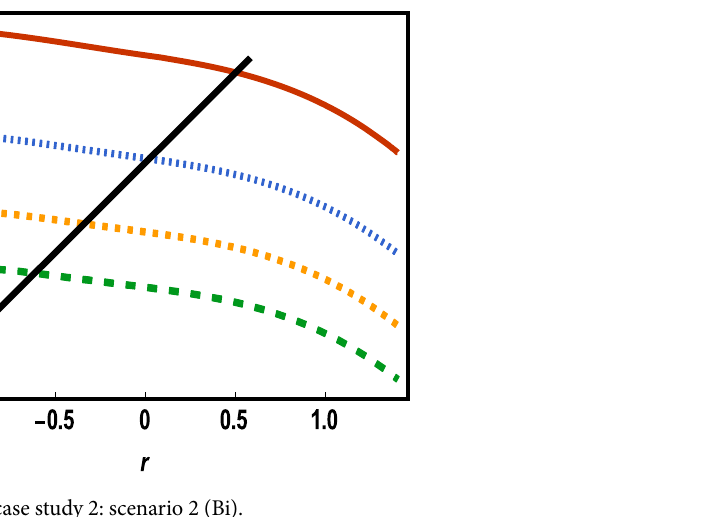
Figure 8. Results of case study 2: scenario 2 (Bi).